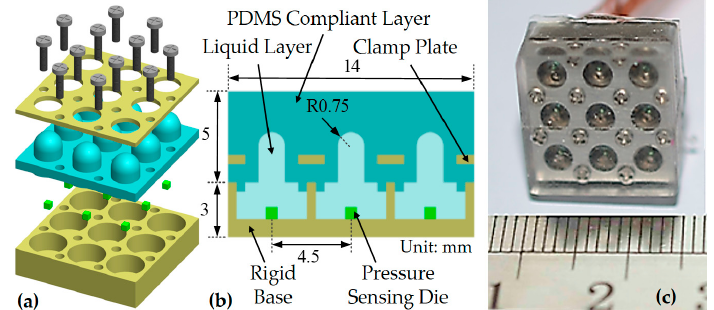
Figure 1. Schematic diagram of the sparse solid–liquid hybrid tactile sensor array structure. ( a ) Explosion diagram of sensor array structure; ( b ) Cross-section diagram of sensor array with continuous planar compliant layer; ( c ) Real prototype of sensor array.